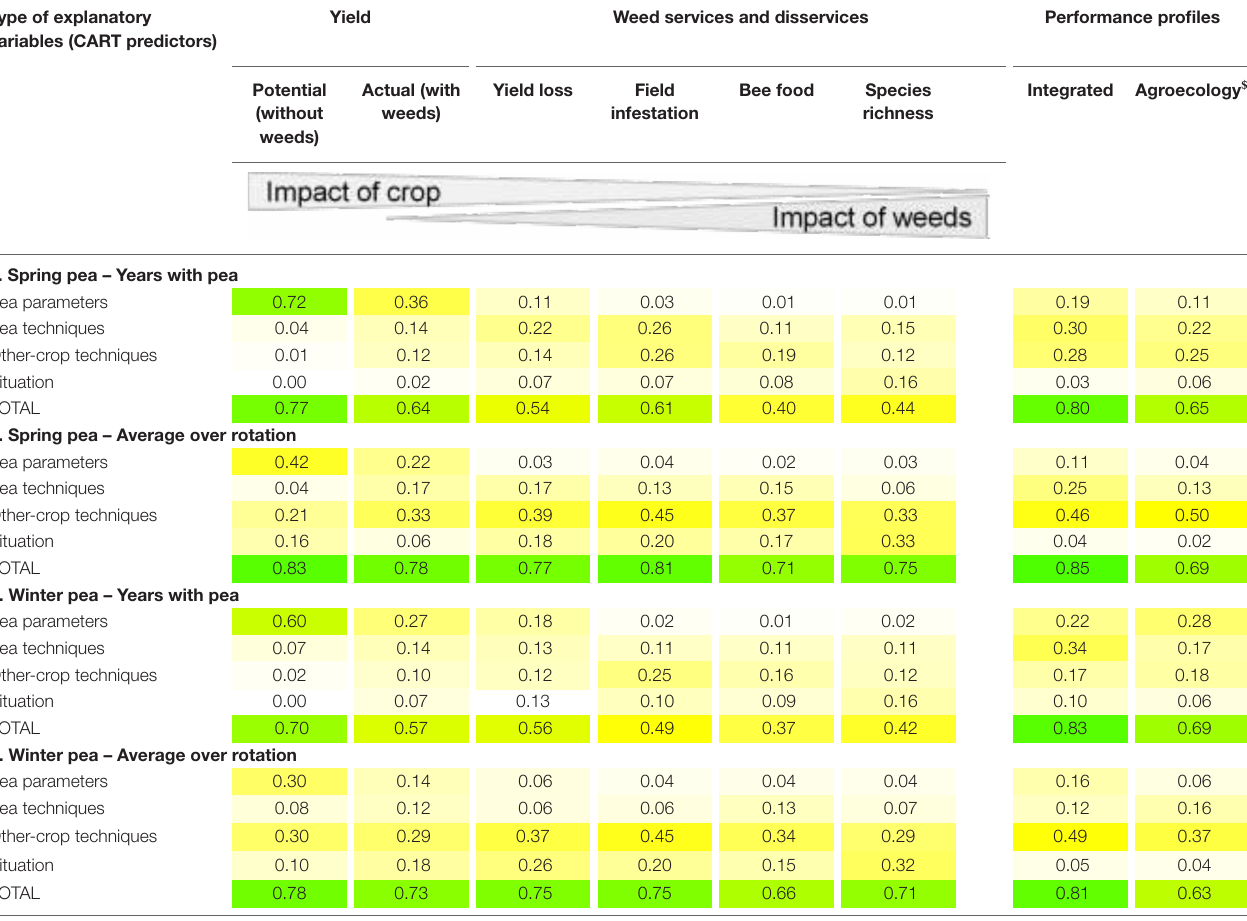
TABLE 3 | Variability in weed (dis)service indicators is explained by the different types of simulation factors. Type of explanatory variables (CART predictors)